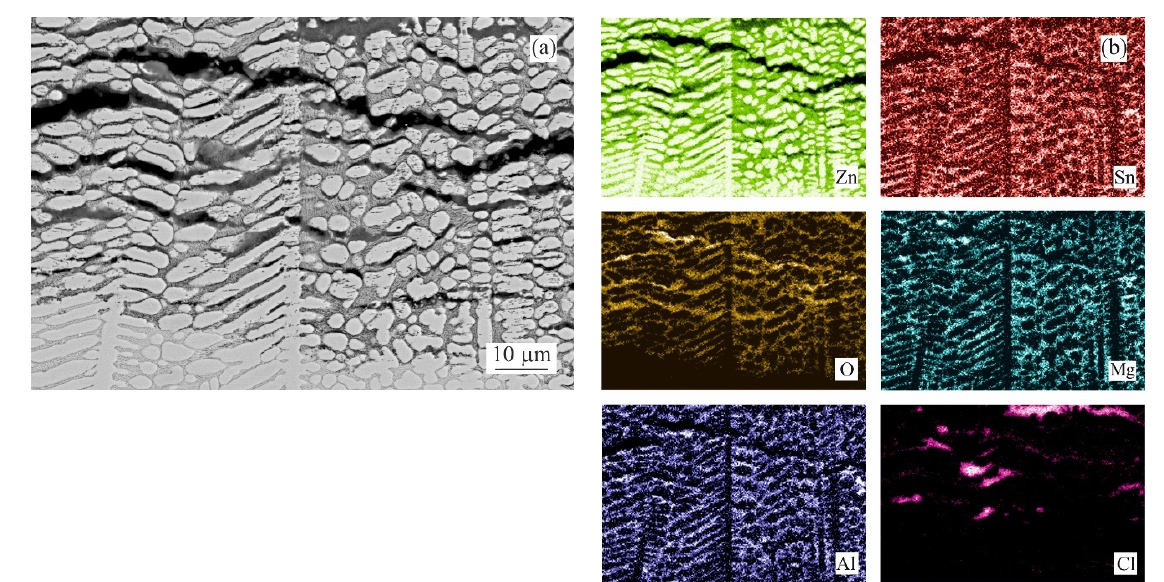
Figure 3. Anchoring effect of η (Zn) dendrites with corroded interdendritic spaces (MZ + 2.0Sn, as-cast): ( a ) overview BSEM image; ( b ) chemical element distribution maps of Zn, Sn, O, Mg, Al and Cl.